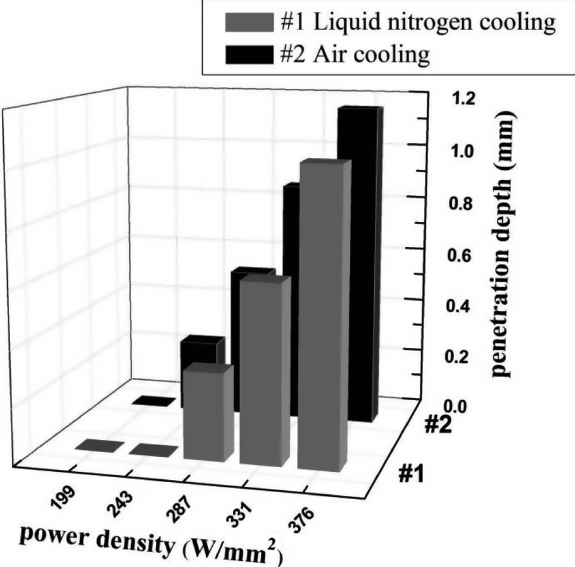
Figure 4: Effect of laser power on penetration depth of laser-melted